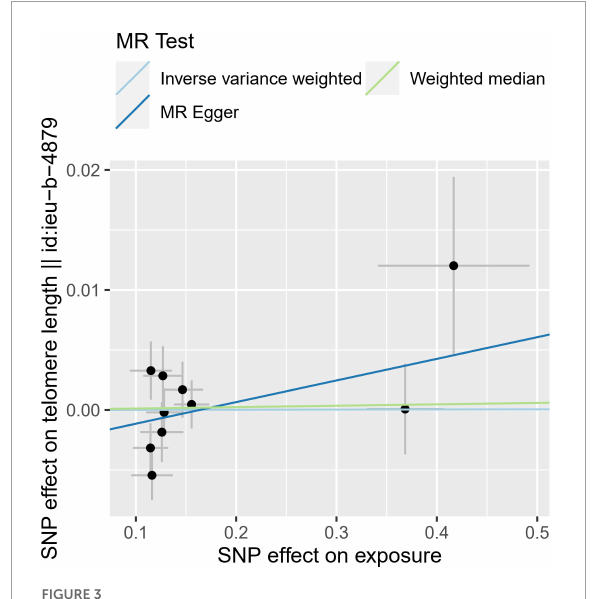
FIGURE3 Individual estimates about the reverse causal effect of calcific aortic valve stenosis (CAVS) on telomere length (TL). The X -axis shows the single nucleotide polymorphism (SNP) effect and standard error (SE) on each of the 10 CAVS SNPs. The Y -axis shows the SNP effect and SE on TL. TL, telomere length; CAVS, calcific aortic valve stenosis; SNP, single nucleotide polymorphism; SE, standard error.